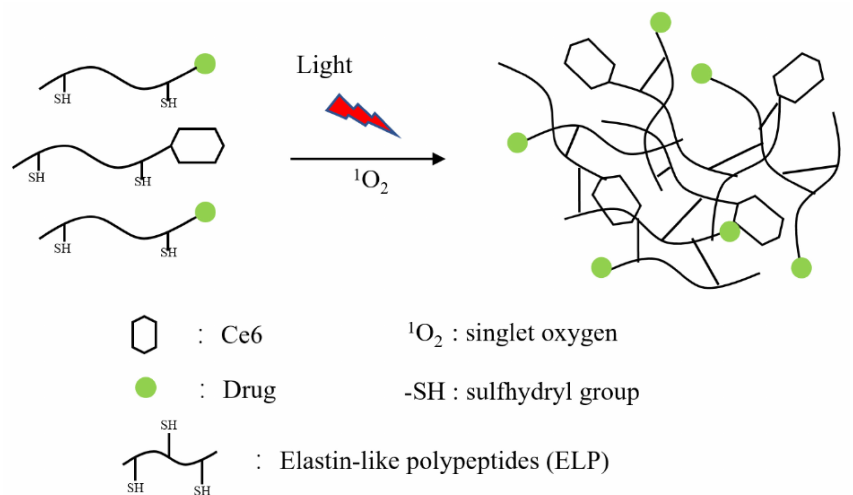
Figure 2. Ce6-ELP crosslinked through disulfide bonds under near-infrared